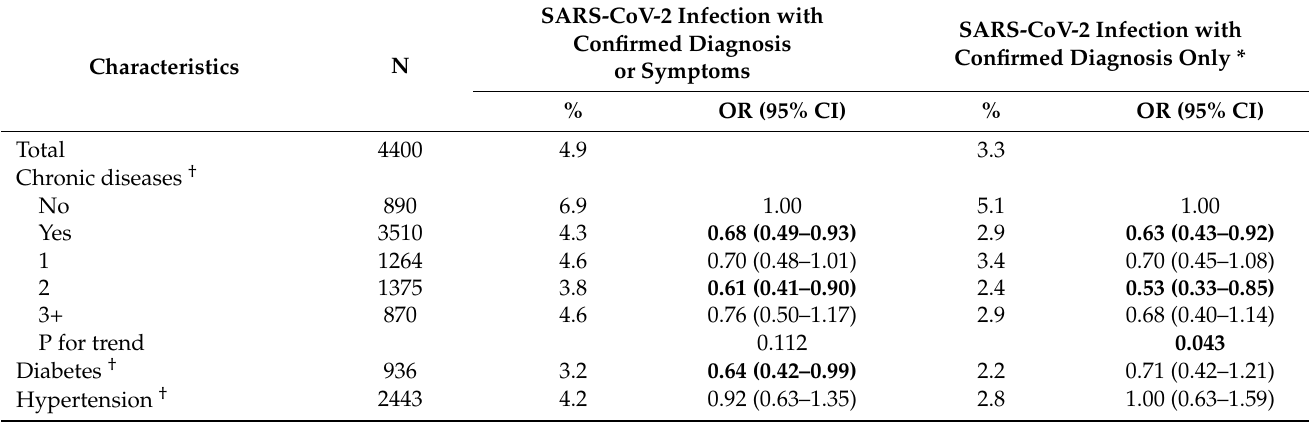
Table 2. Distribution of 4400 Italian subjects aged 65 years or above according to SARS-CoV-2 infection, overall and by chronic conditions. Corresponding odds ratios ˆ (OR) and 95% confidence intervals (CI). Lombardy region, Italy,